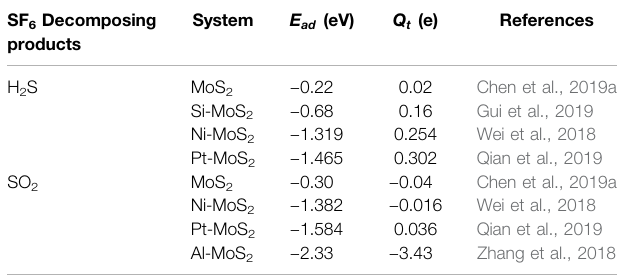
TABLE 1 | Comparison of adsorption parameters for H 2 S and SO 2 in different